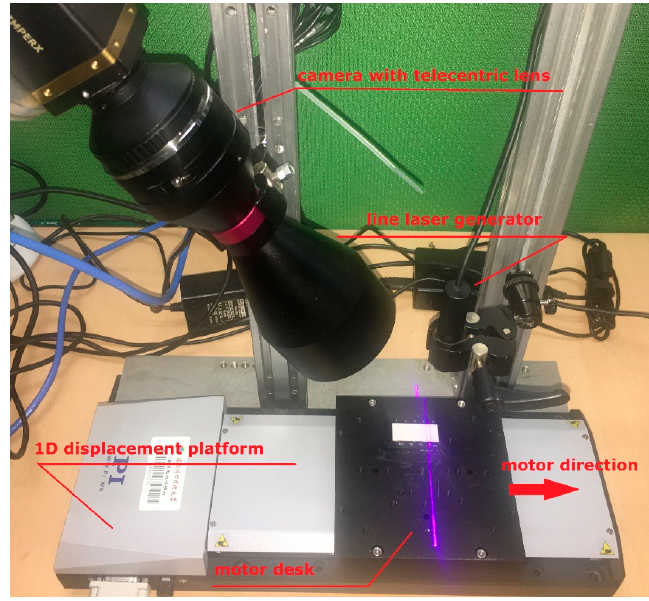
Figure 9. Experimental setup of the proposed telecentric surface reconstruction system. Table 1. Calibration parameters in experiments.